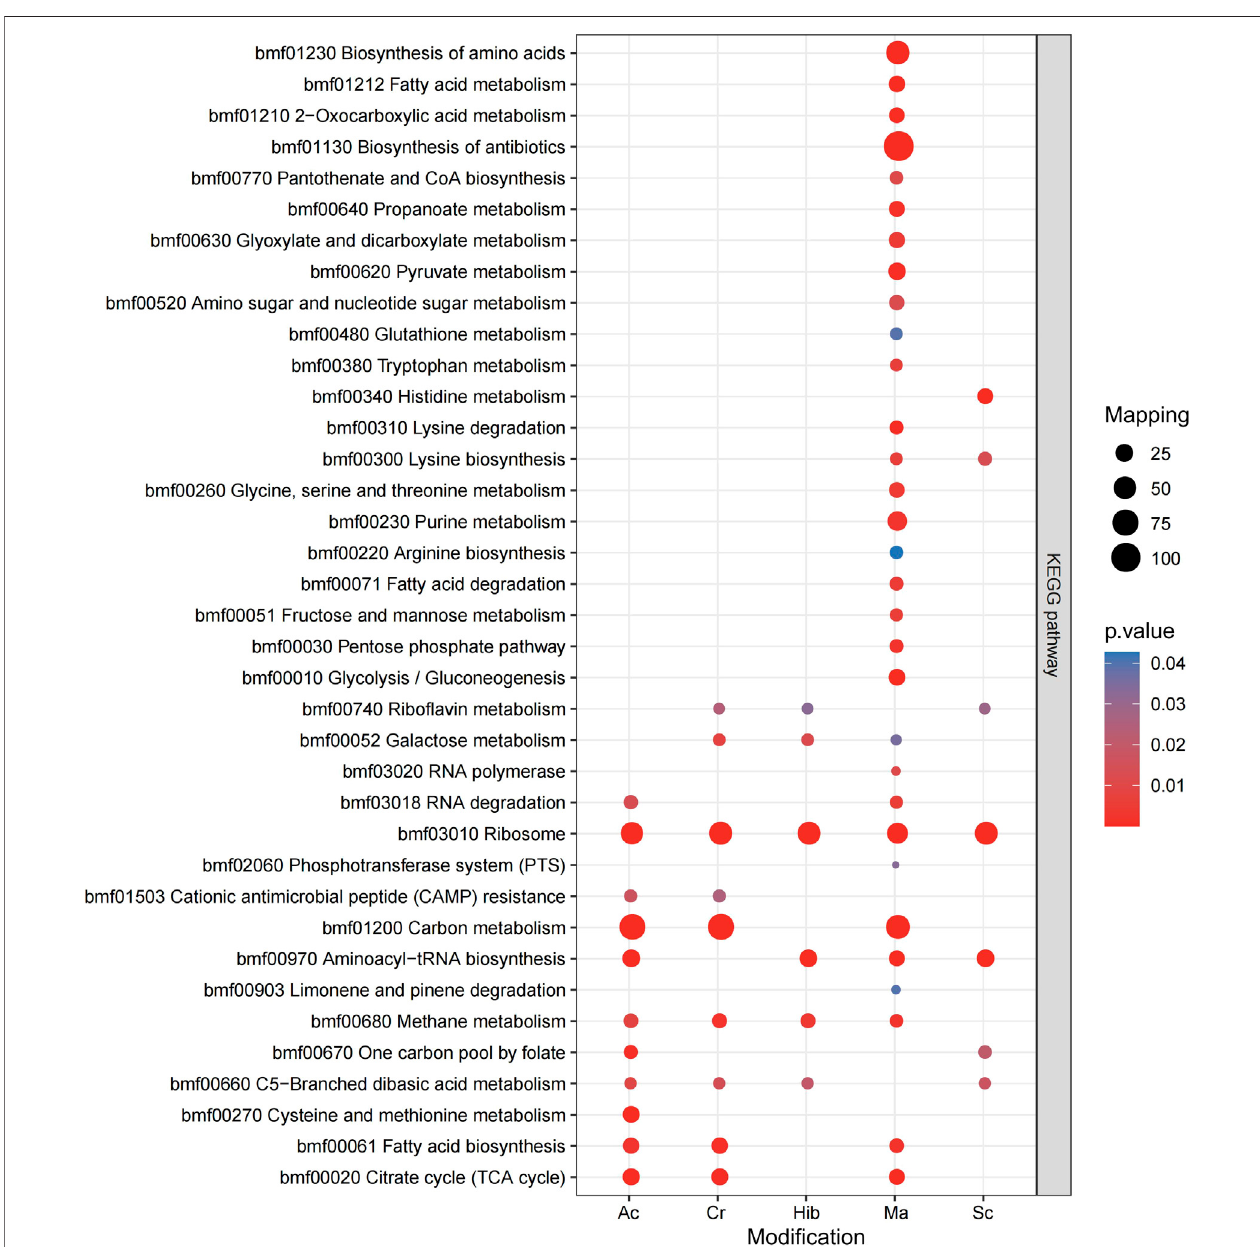
FIGURE 5 | KEGG pathway enrichment bubble plot of proteins corresponding to modi fi cation sites.